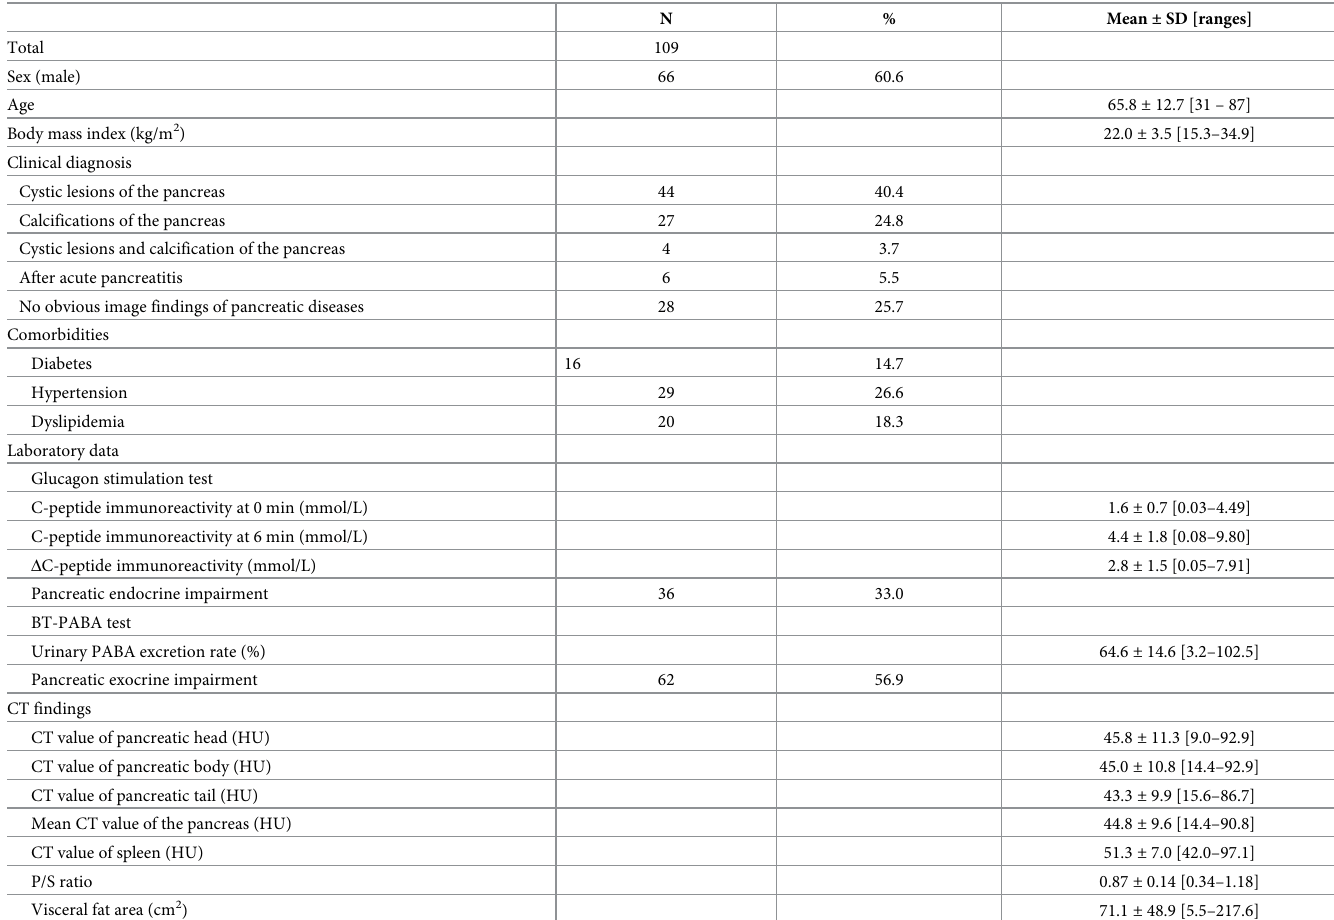
Table 1. Characteristics of the